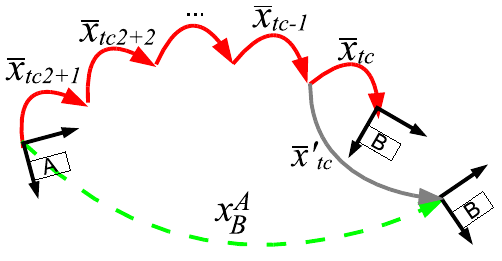
Figure 12. The pose correction process. Only one item in the transformations history is changed to meet the scan matching